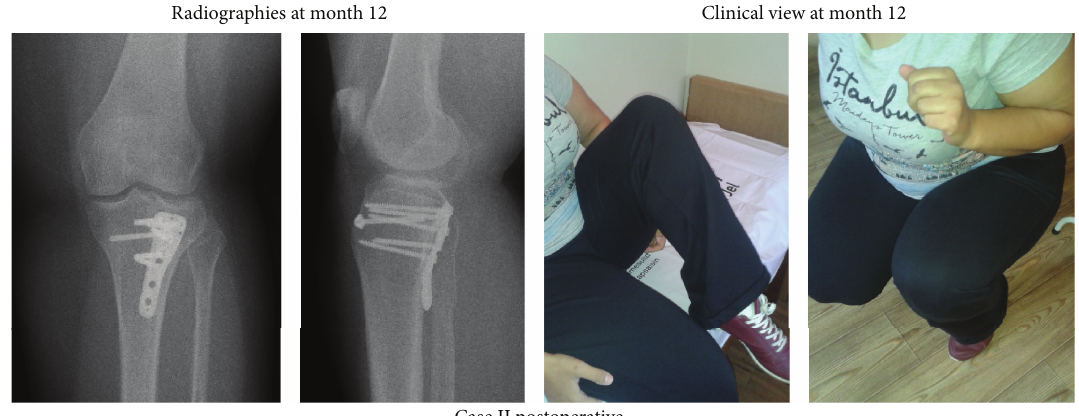
Figure 5: Postoperative 12th month radiographies and clinical view of Case